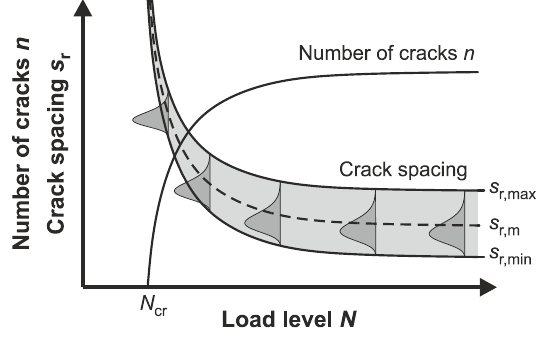
Figure 16. Crack spacing and number of cracks versus the load level.